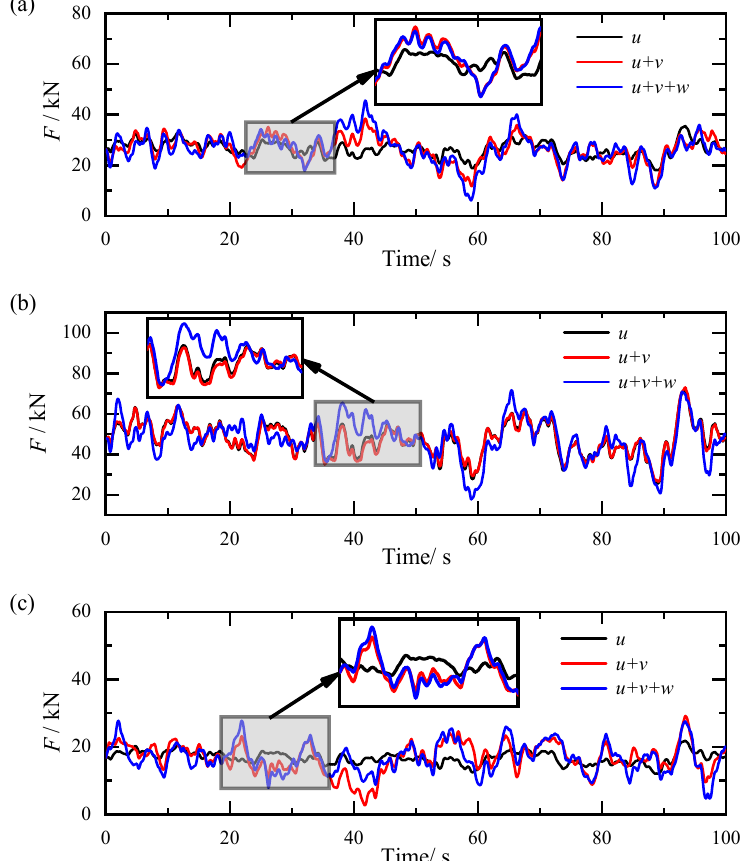
Figure 21. Simulated unsteady side force time histories at different crosswind angles ( U = 20 m/s, V V = 300 km/h): ( a ) α = 30°, V R = 101.1 m/s, β = 5.7°; ( b ) α = 90°, V R = 85.7 m/s, β = 13.5°; ( c ) α = 150°, V R = 66.7 m/s, β = 8.6°.